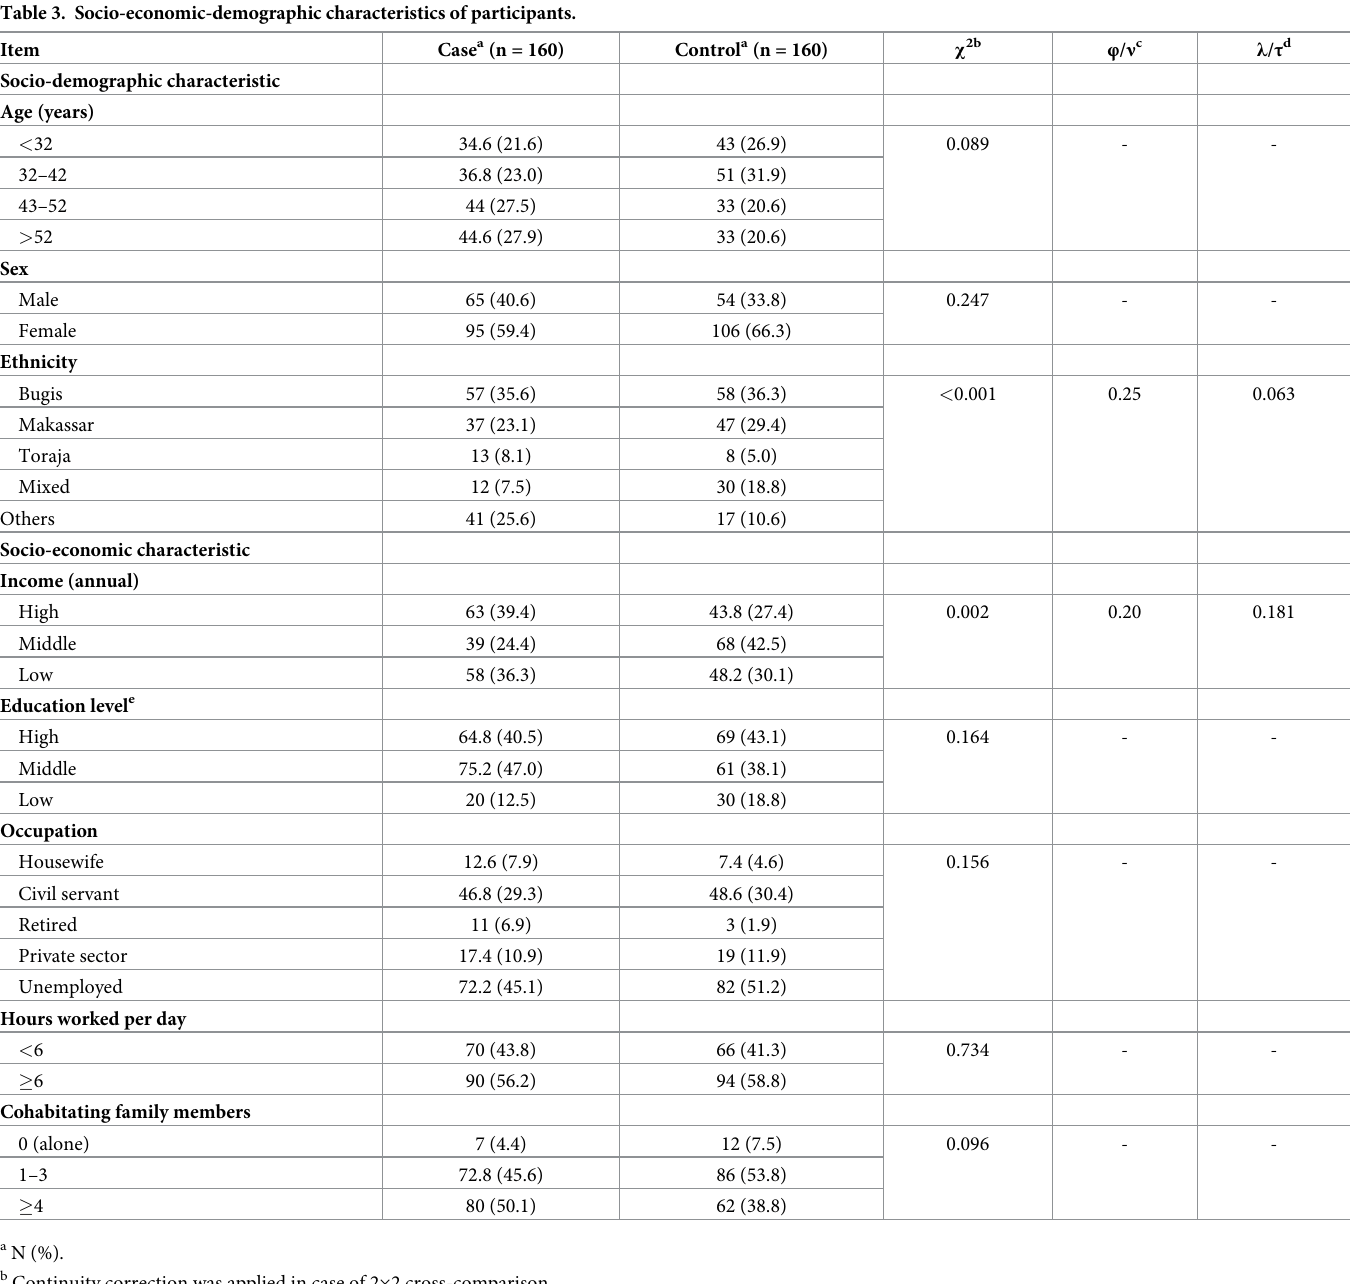
Table 3. Socio-economic-demographic characteristics of